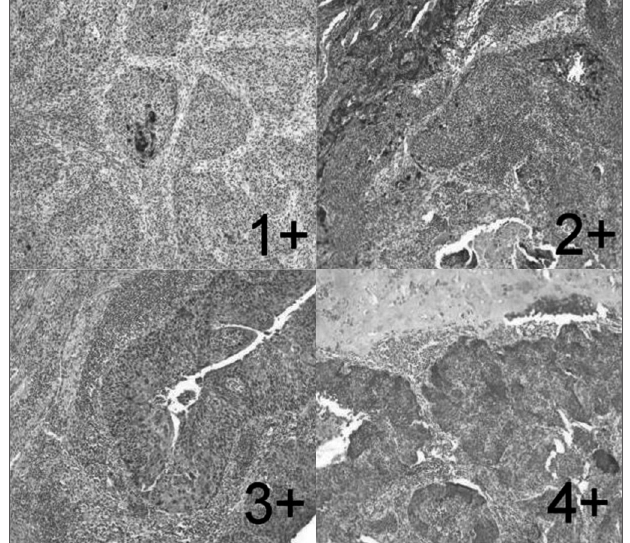
Figura 1. Peça de laringe de carcinoma espinocelular após reação imunohistoquímica com expressão de psoriasina S100 A7. Escores 1+, 2+, 3+ e 4+ (Ampliação